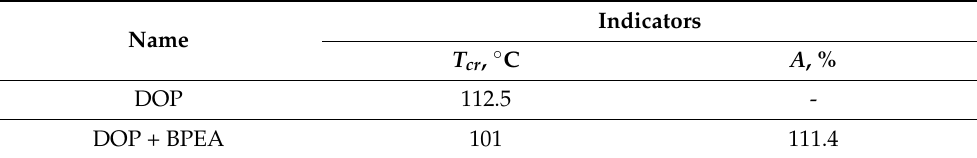
Table 2 . The results of determining the critical temperature of dissolution of PVC resin in the plas- ticizer .